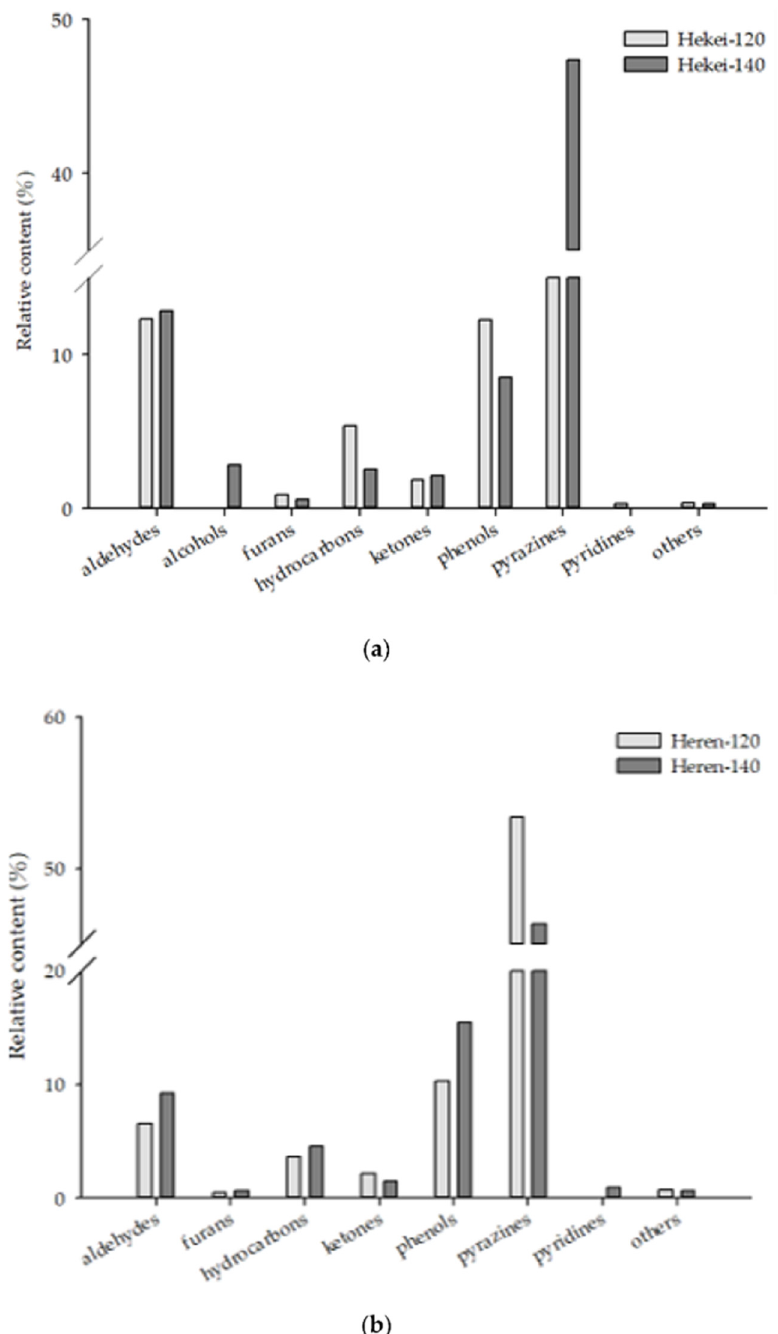
Figure 5. Classification of volatile compounds in Tainan S. No. 16 peanut oils using HS-SPME. ( a ) Tainan S. No. 16 with peanut shell peanut oil at different roasting temperatures. ( b ) Tainan S. No. 16 peanut oil at different roasting